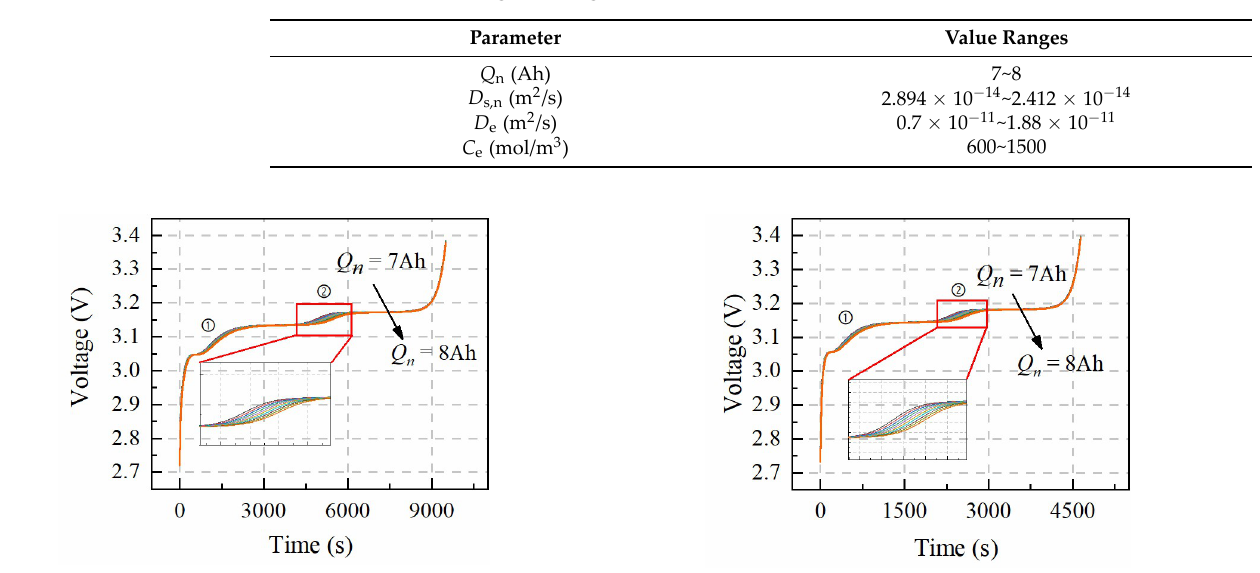
Table 3. Parameter ranges setting.